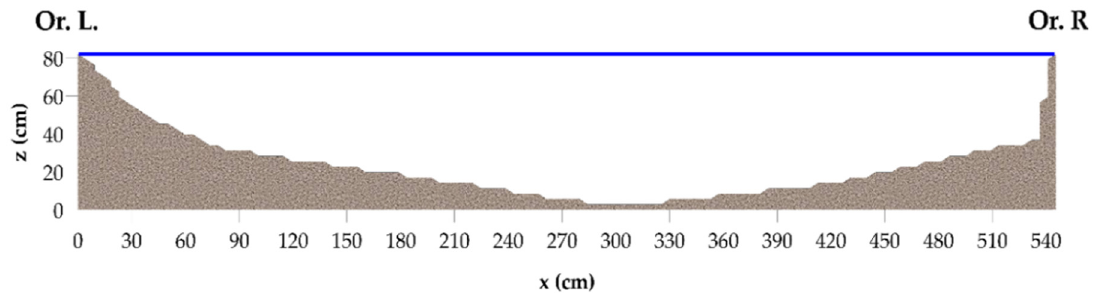
Figure 4. Acoustic Doppler velocimeter (ADV) cross section. The continuous dark blue line indicates the water level at bankfull.